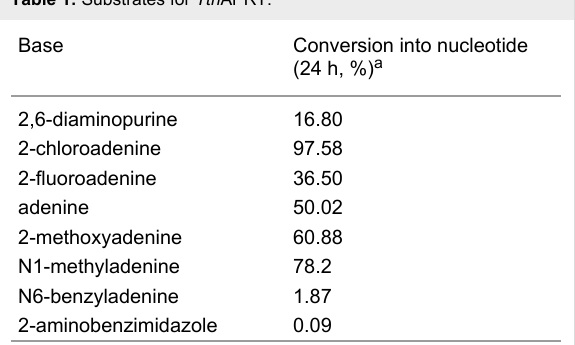
Table 1: Substrates for Tth APRT.